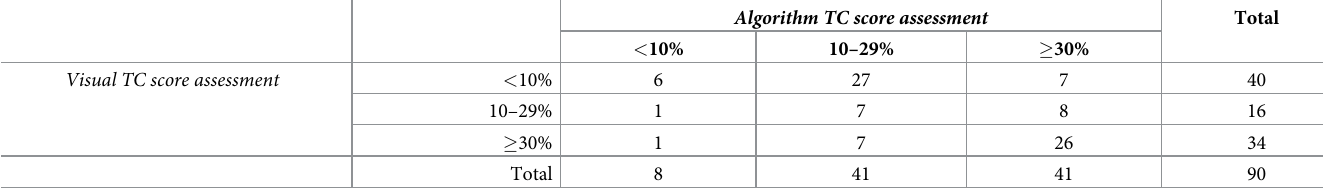
Algorithm TC score assessment